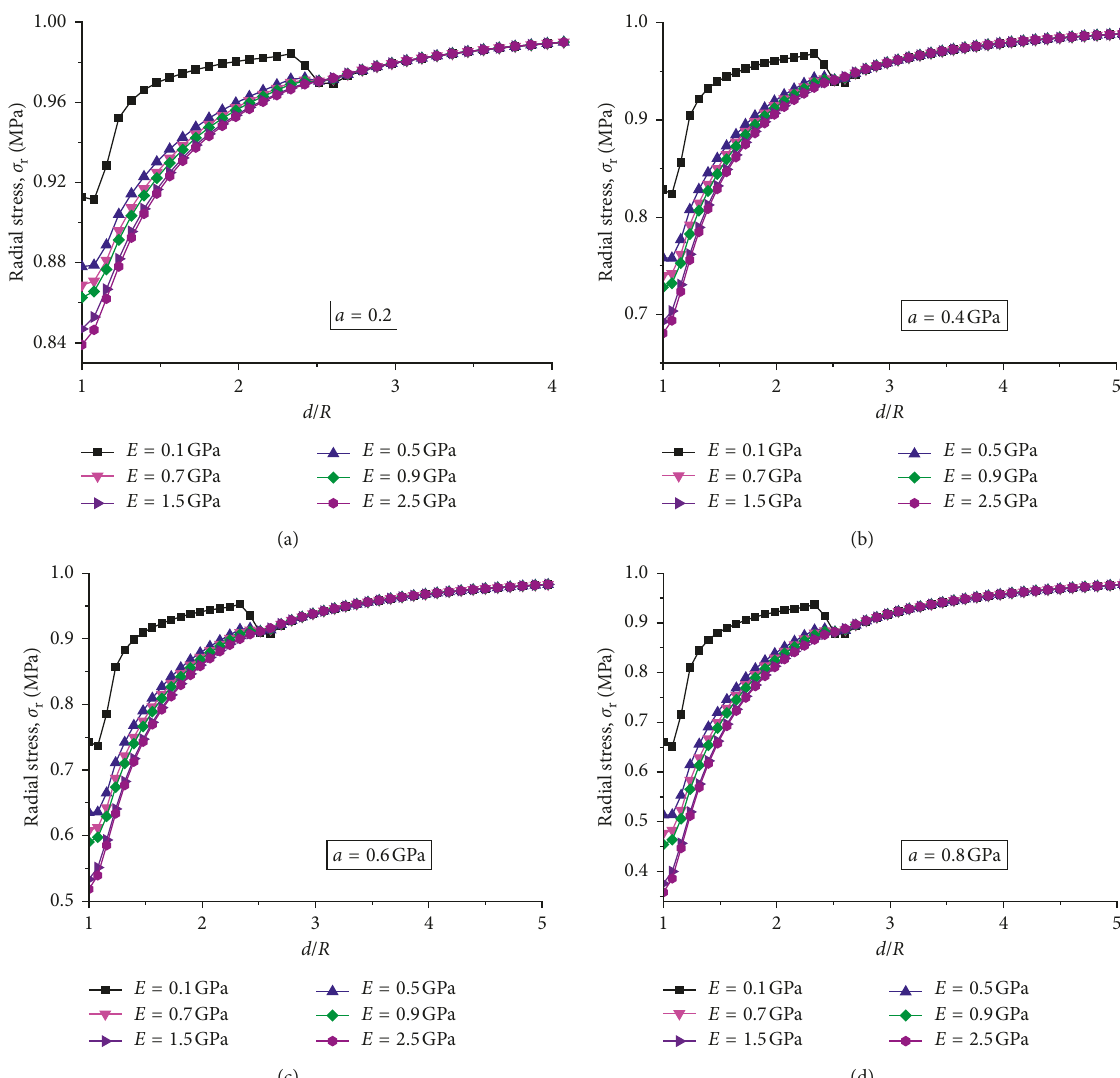
Figure 14: Stress distribution with different surrounding rock